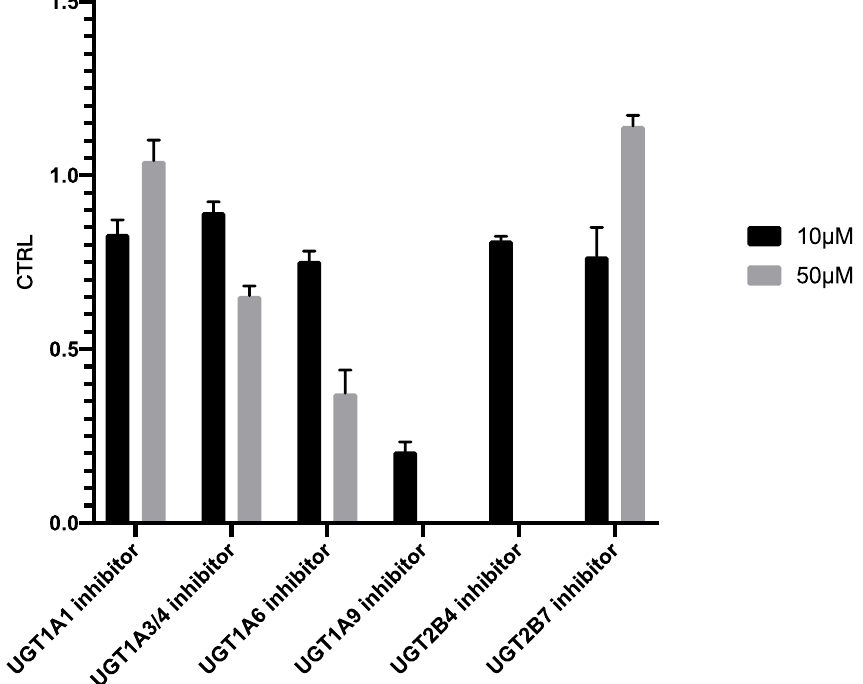
Figure 8. Inhibition of propylthiouracil glucuronidation in HLMs by different UGT inhibitors. Each point represents the average of three replicates.